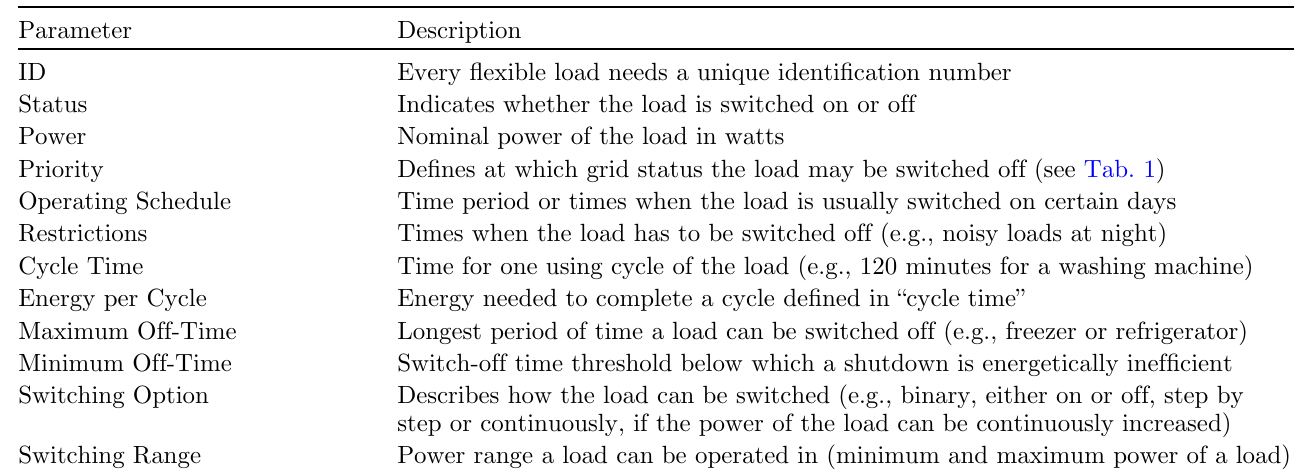
Table 2. Load speci fi c